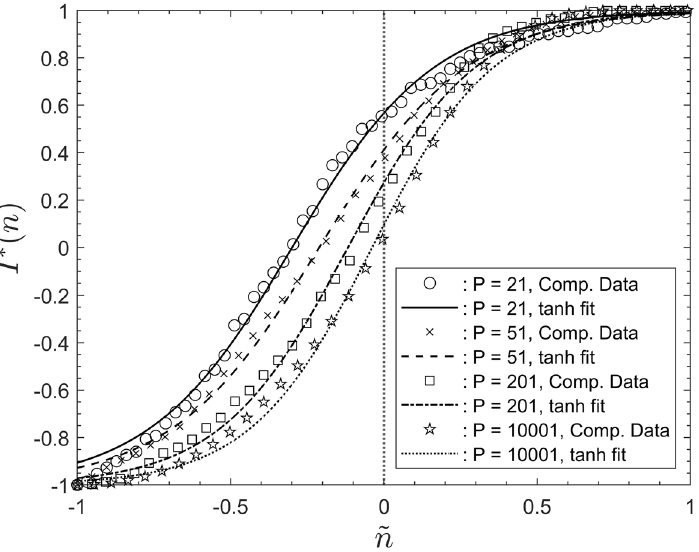
∗ as a function of the